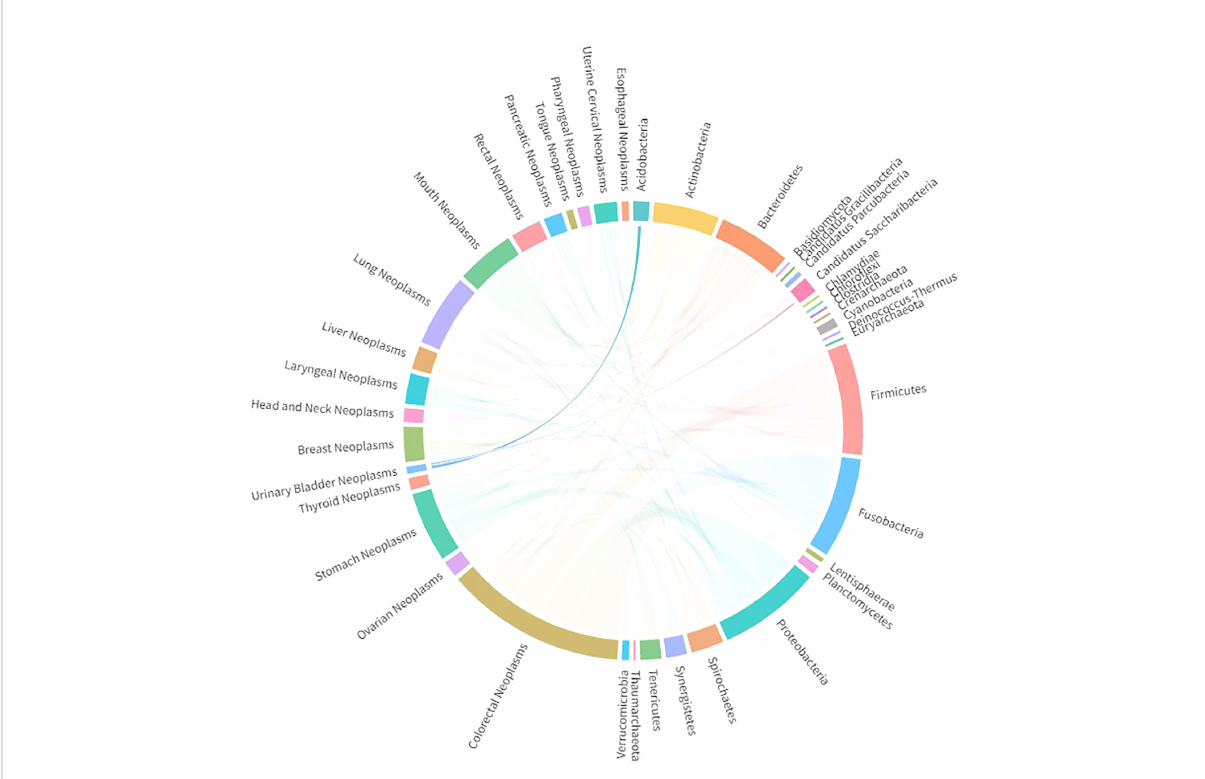
FIGURE 1 Signi fi cantly associated bacteria phyla detected in bladder cancer patients, extracted from DIANA Lab